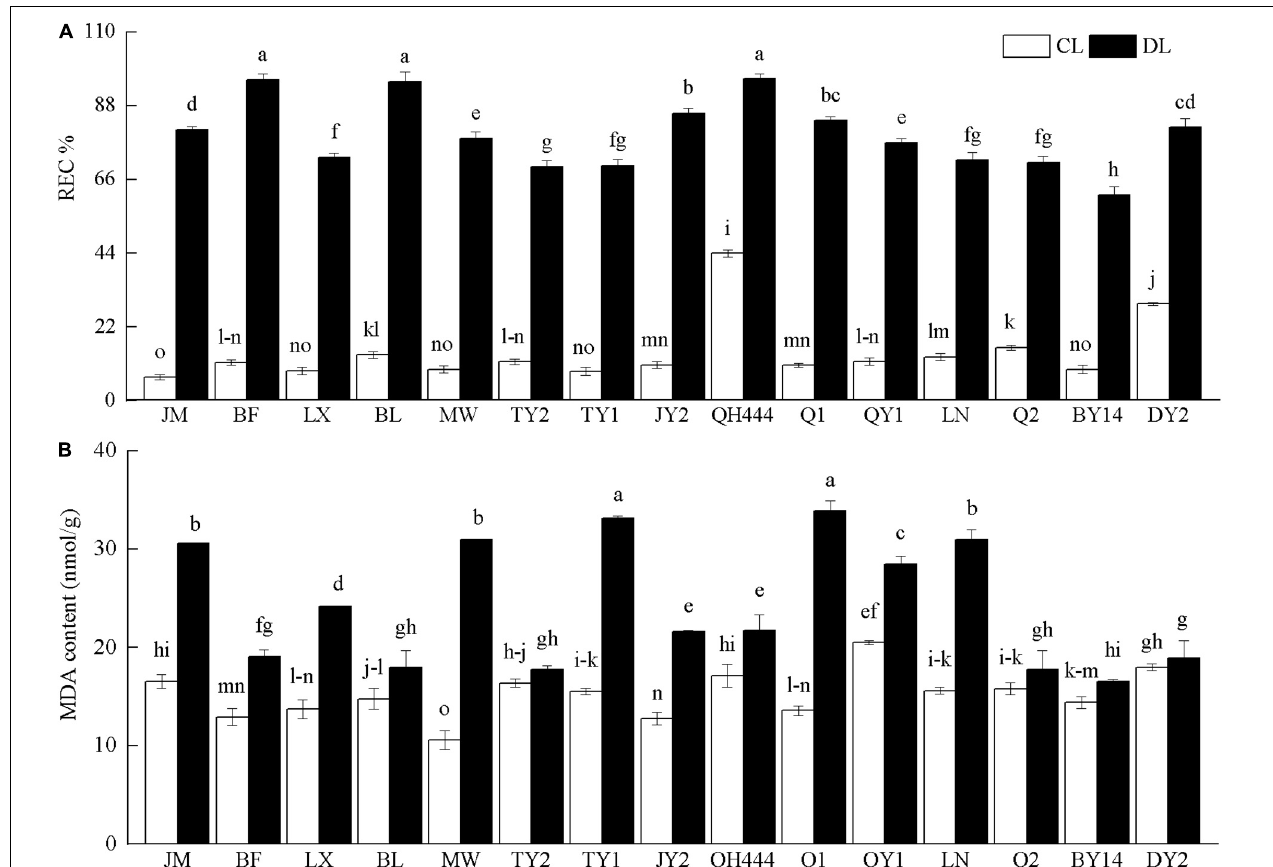
FIGURE 4 | Relative electrical conductivity (REC%) (A) and malondialdehyde (MDA) content (B) in oat varieties under drought stress. Each value represents the mean ± standard deviation. Each experiment was repeated three times. An analysis of variance test was performed, followed by Tukey test. CL, untreated control; DL, drought stress. Different letters indicate that the differences between treatments were significant ( P <